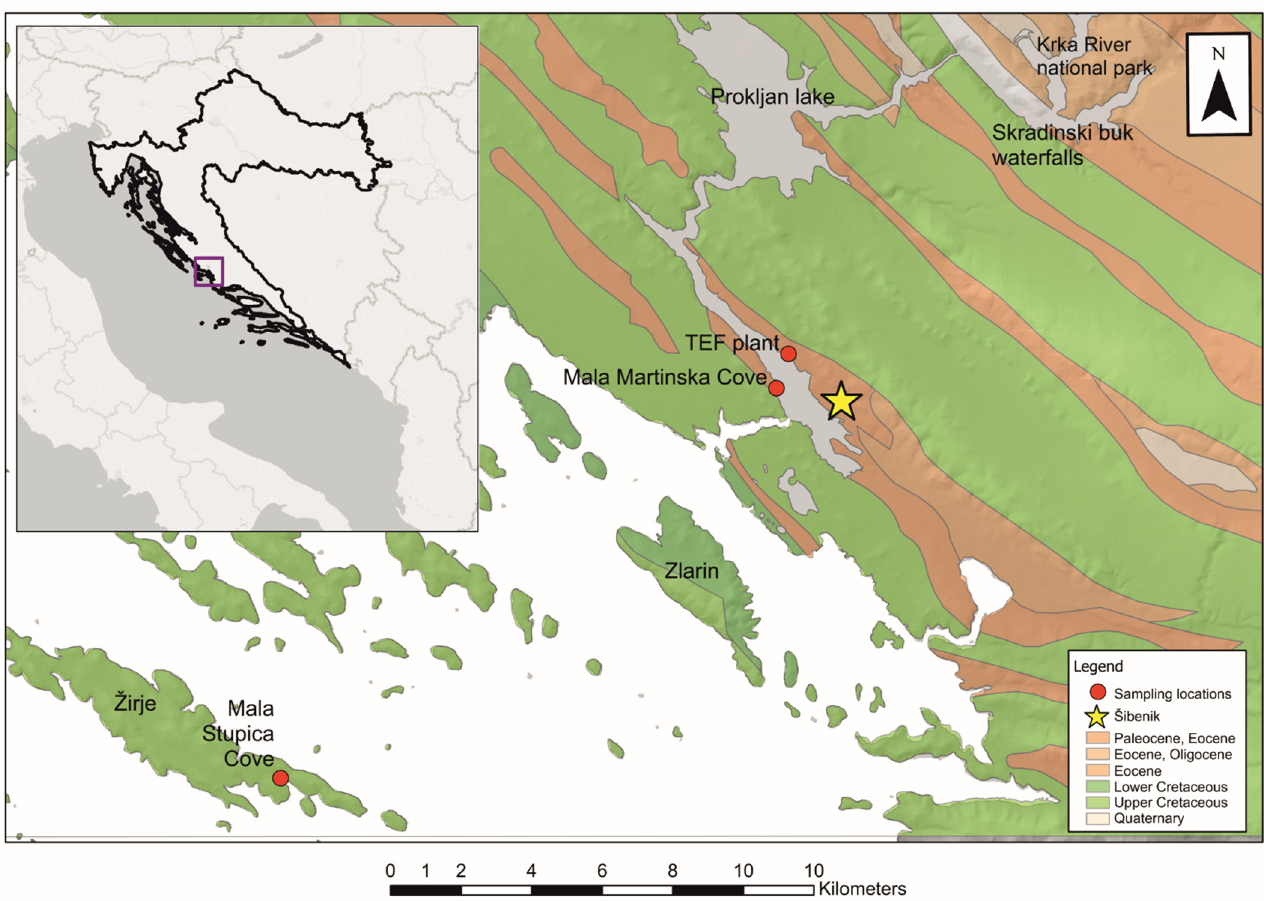
Figure 1. Geological map [16,17] of the study area with sampling locations marked (red dots) and the position of town of Šibenik (yellow star).